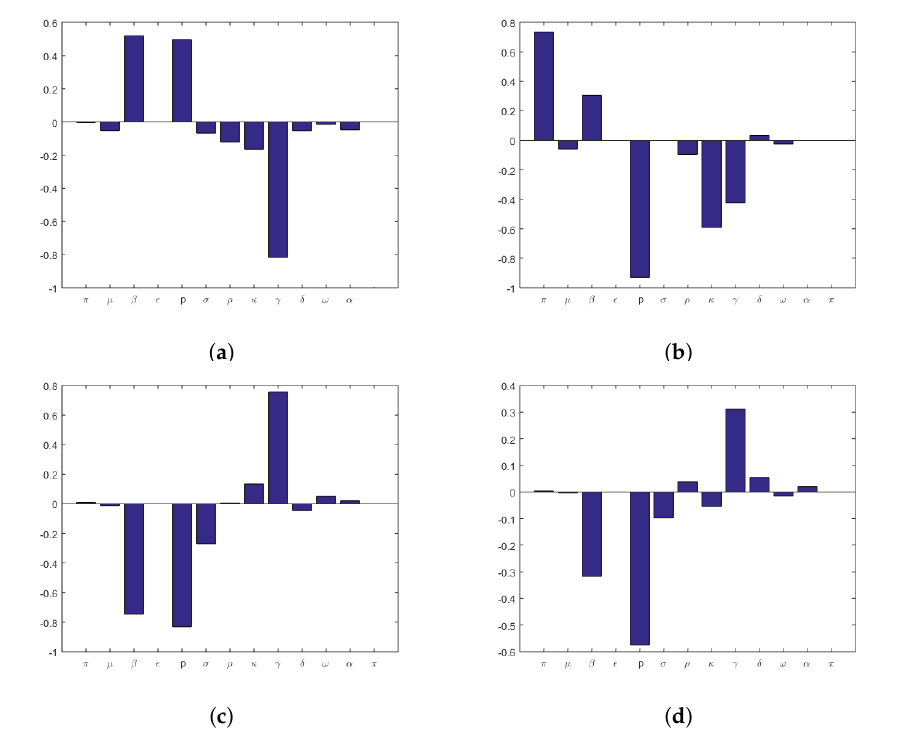
Figure 3. PRCCs for I s during the COVID-19 waves. ( a ) Wave 1. ( b ) Wave 2. ( c ) Wave 3. ( d ) Wave 4. Table 1. Parameter values for COVID-19 waves 1 and 2. While, some of the parameter values were obtained from literature, those with some given intervals were estimated to be between the minimum and maximum values depicted in the